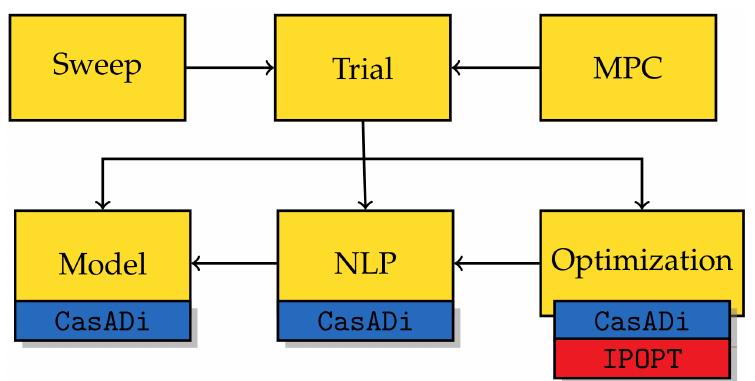
Figure 2. Main AWEbox classes (Python) and overall software structure, including